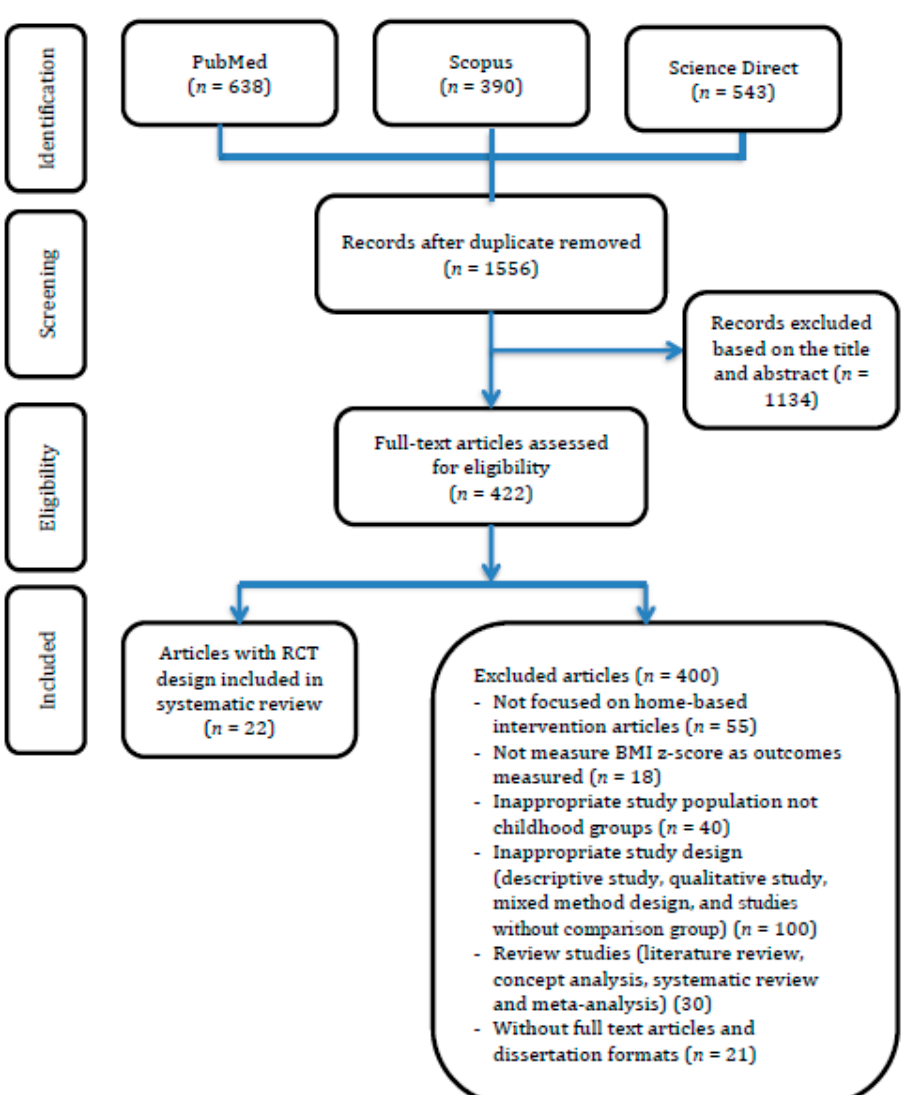
Figure 1. Summary of evidence-based searching process and selection criteria. RCT: randomized controlled trial; Body mass index (BMI)